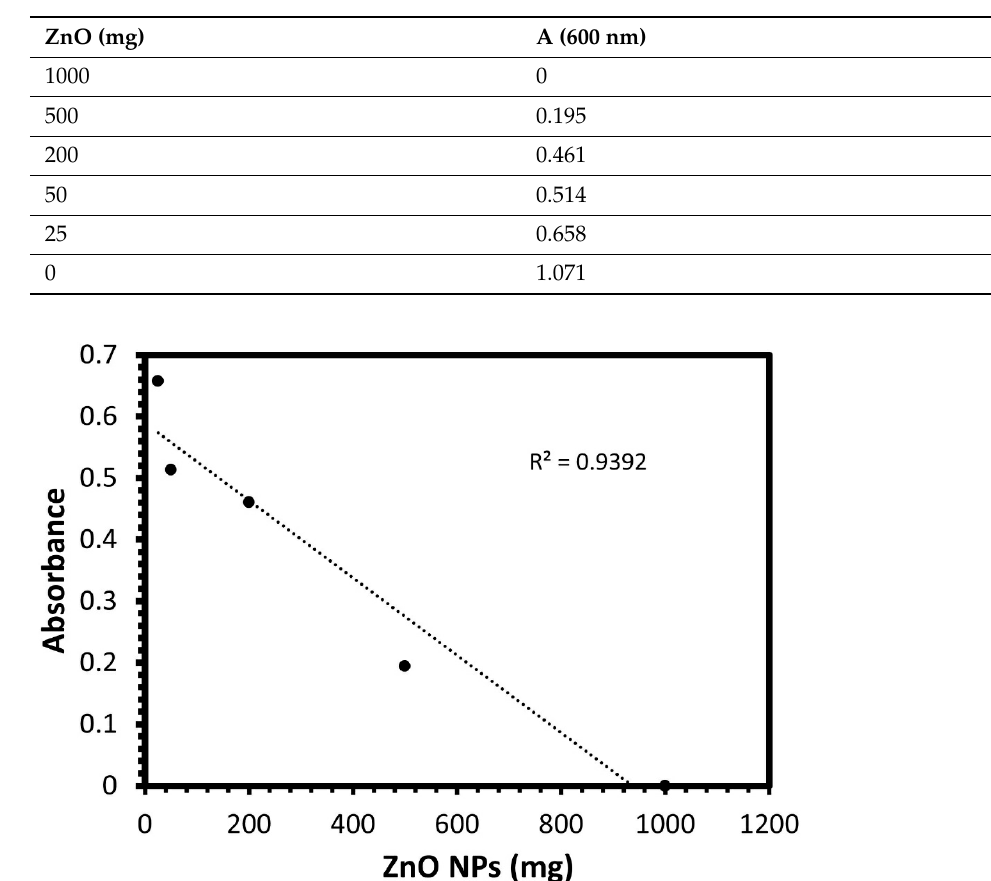
Figure 4. The optical density at 600 nm for E. coli bacteria in various dosages of green biosynthesized ZnO NPs. Table 2. Antibacterial activity of ZnO NPs aqueous solution method (using nutrient broth shake flask test). Concentration of Green Biosynthesized ZnO NPs ( μ g/mL)